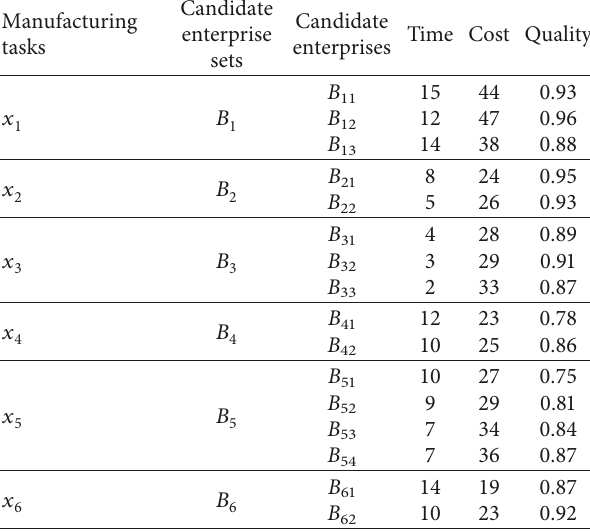
Table 6: Candidate manufacturing enterprise information.